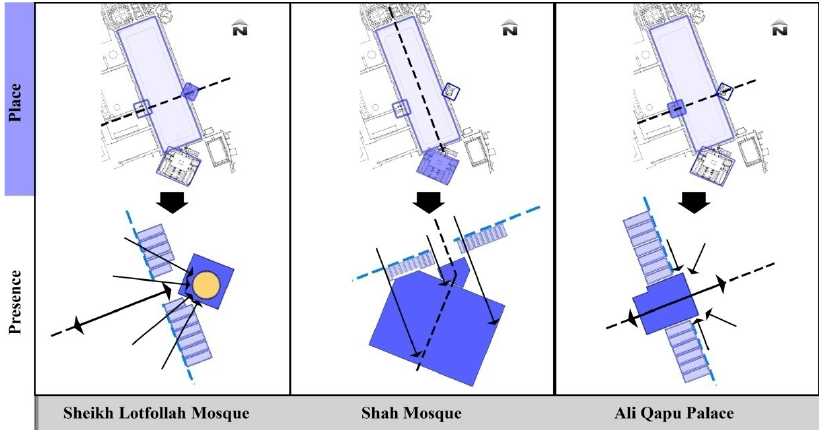
Figure 2. The particular modes of hierarchy are the main solution for bestowing of presence in Naghsh-i Jahan